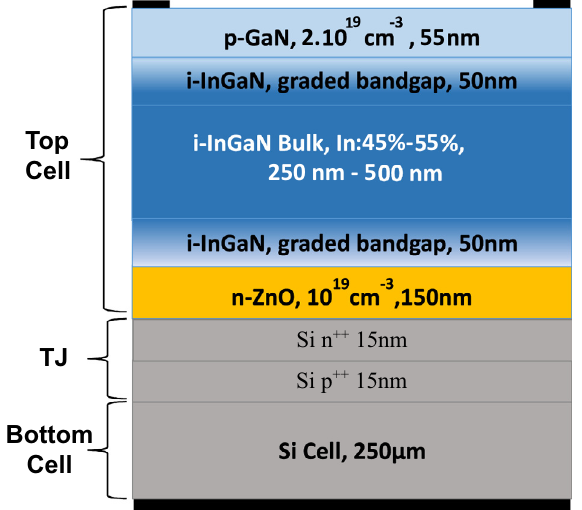
Fig. 1. Modeled structure for InGaN/Si 2-terminal tandem cell. Top cell structure is based on the work of reference [15], and bottom cell structure is based on the work of reference